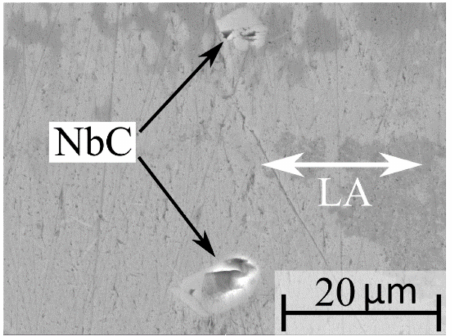
Figure 4. SEM image in SE contrast of the surface of the REF material before the fatigue experiment including the NbC precipitates verified by the EDS